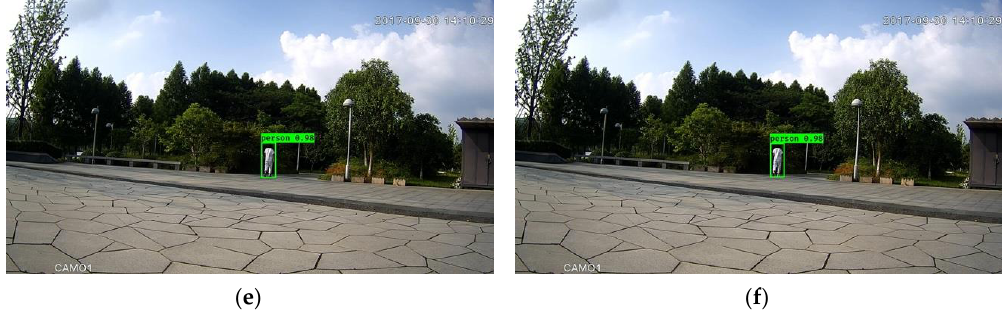
Figure 3. Outcomes of the framework without downsampling ( a,c,e ) and with downsampling ( b,d,f ).